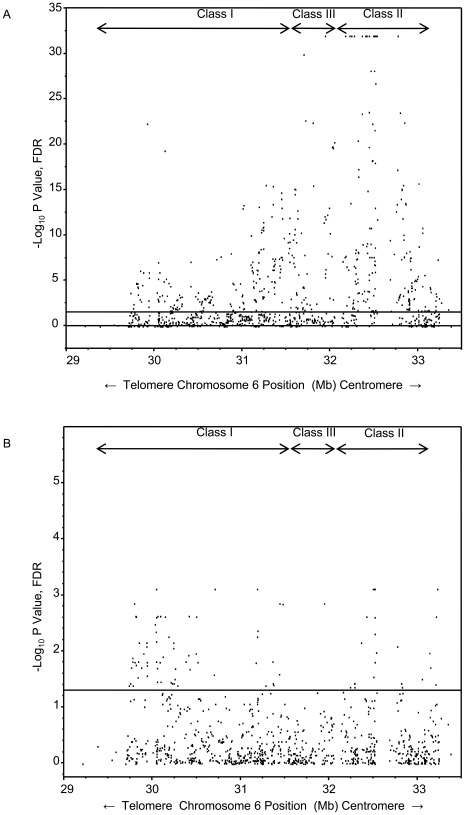
Association test results for 958 SNPs spanning the MHC in the discovery dataset are shown.The location of the SNPs is depicted on the X-axis and the statistical significance of the association is depicted on the Y-axis. A: Discovery dataset (1018 cases and 1795 controls), 958 common SNP subset, FDR = .05, adjusted for sex and center (US versus UK), trend test. B: Discovery dataset, 958 common SNP subset, FDR = .05, adjusted for the HLA-DRB1*15:01 tagging SNP rs3135391), sex and center (US versus UK), trend test.